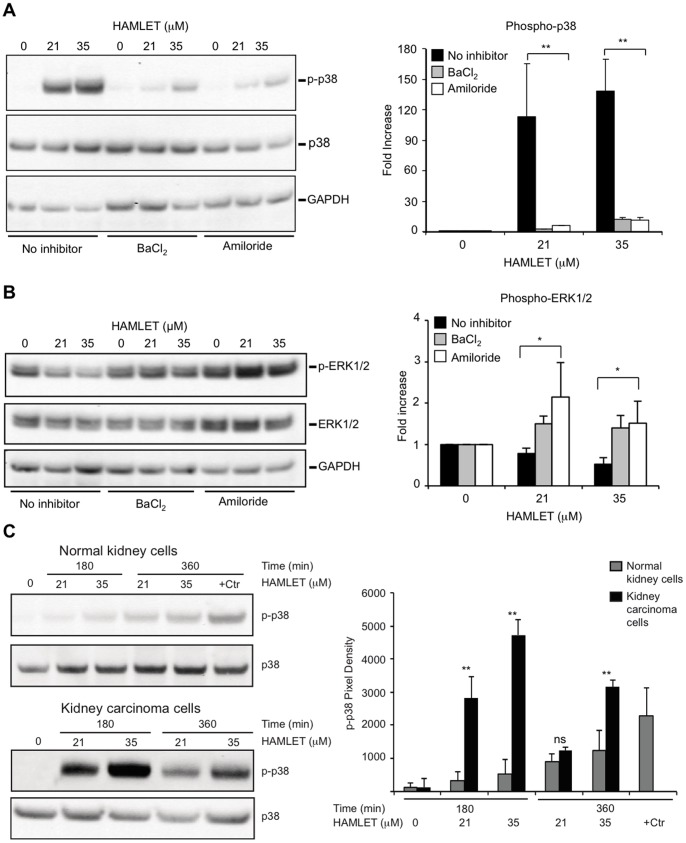
Ion channel inhibitors reduce protein phosphorylation.Amiloride or BaCl2 reduced phosphorylation of targets in the p38 signaling Lung carcinoma cells were exposed to HAMLET (21 and 35 µM) for 1 hour, protein lysates were blotted, incubated with antibodies as noted in the figure and quantified using ImageJ (Representative blot,+SEMs of 2–3 independent experiments). (A) Amiloride or BaCl2 (1 mM, 30 minutes pretreatment) inhibited HAMLET-induced p38 MAPK phosphorylation (B) Amiloride and BaCl2 reverse the suppression of p-ERK1/2 phosphorylation by HAMLET. (C) Difference in phosphorylation of p38 MAPK between normal differentiated cells (HRTEC) and kidney carcinoma cells, visualized by phospho-specific antibodies.